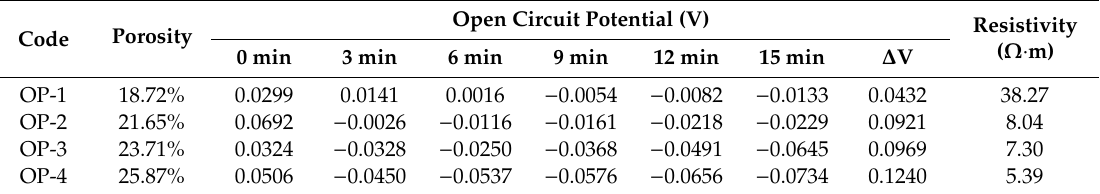
Table 6. Change of open circuit potential with time of different porosity specimens.